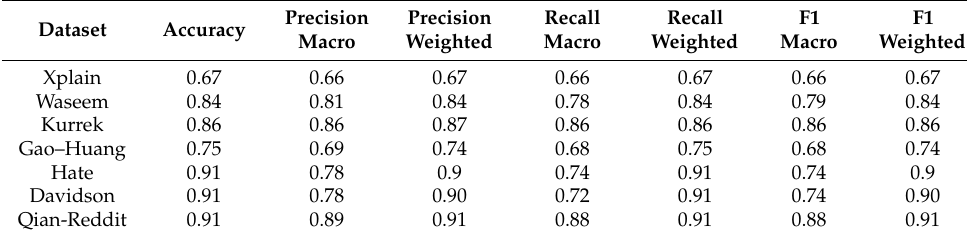
Table 1. BERT token embeddings.